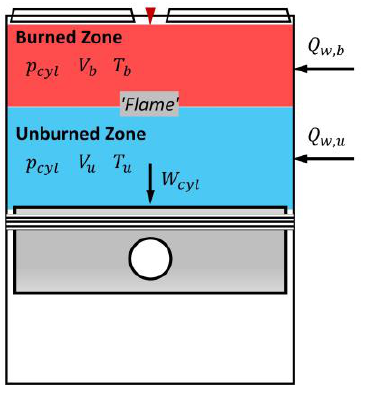
Figure 2. Schematic of a conventional two-zone thermodynamic model.